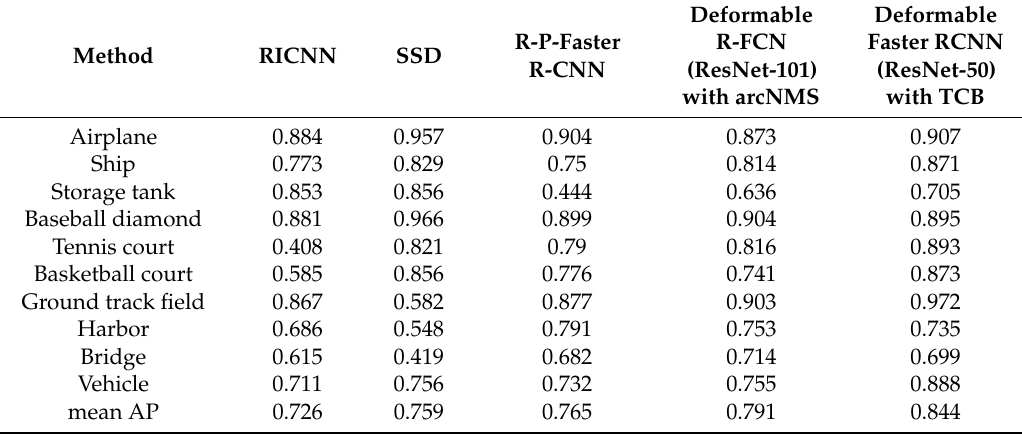
Table 1. The AP values of the object detection methods on the NWPU VHR-10